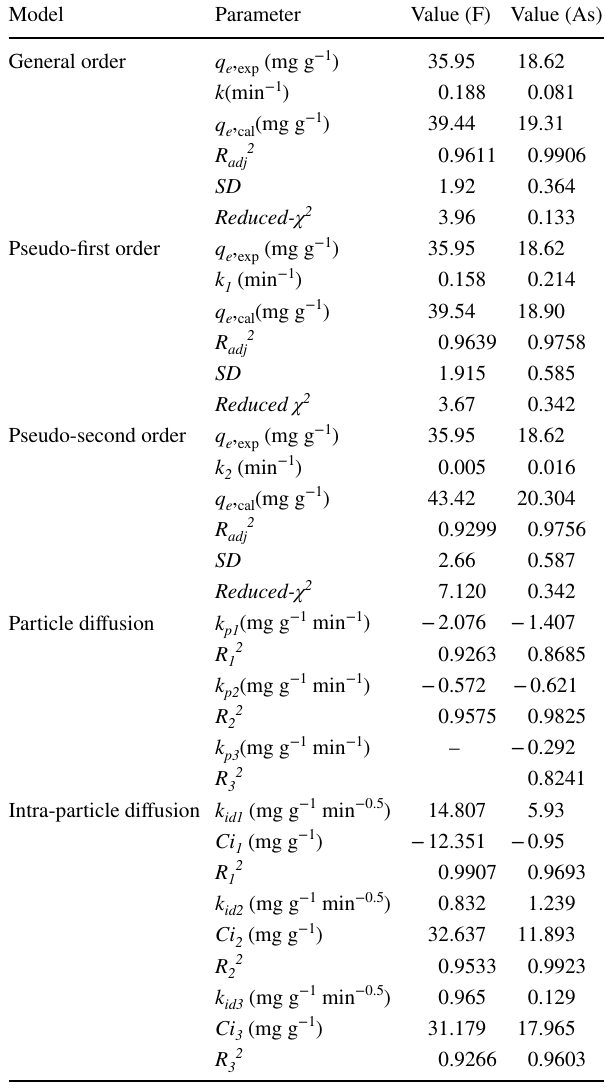
Table 4 Adsorption kinetics and goodness to fit parameters for F − and As 3+ adsorption on nano-adsorbent